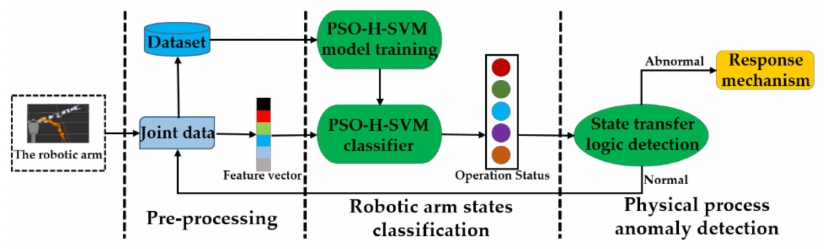
Figure 1. The whole process of the intrusion detection